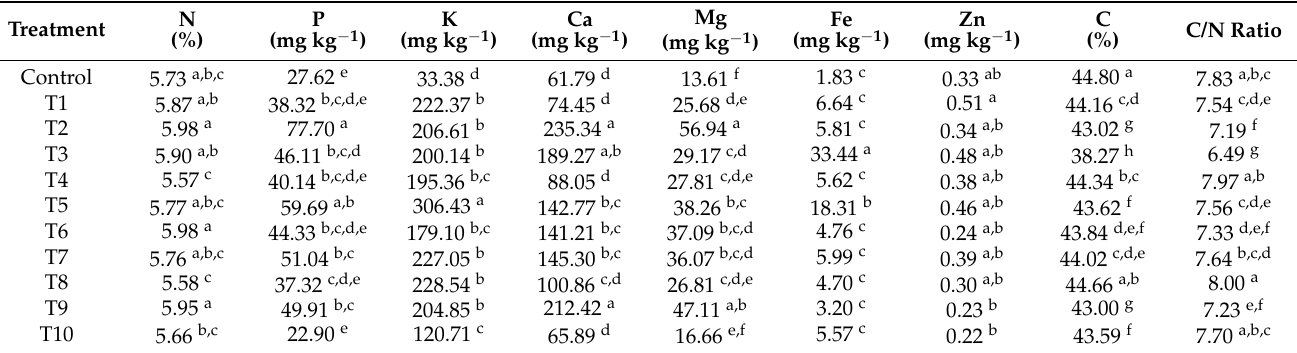
Table 4. C, N, C/N, and mineral concentration of